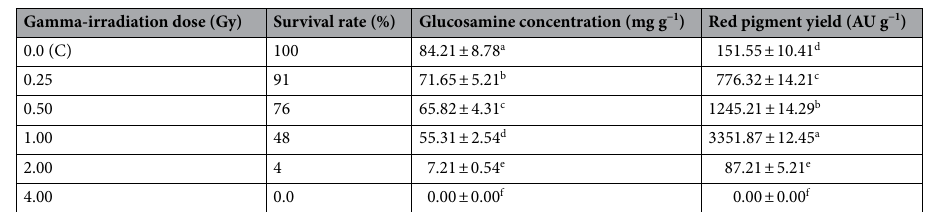
Table 2. Survival rate (%), fungal growth (mg glucosamine g −1 dry fermented substrate) and red pigment production (AU g −1 dry fermented substrate) of M. ruber SRZ112 grown under SSF at different doses of gamma irradiation. Solid–state grown cultures were grown on potato peel moistened with MSB (pH 6.0) incubated at 30 °C for 10 days. Calculated mean is for triplicate measurements from two independent experiments ± SD, a–f means with different superscripts in the same column either for carbon or nitrogen sources are considered statistically different (LSD test, P ≤